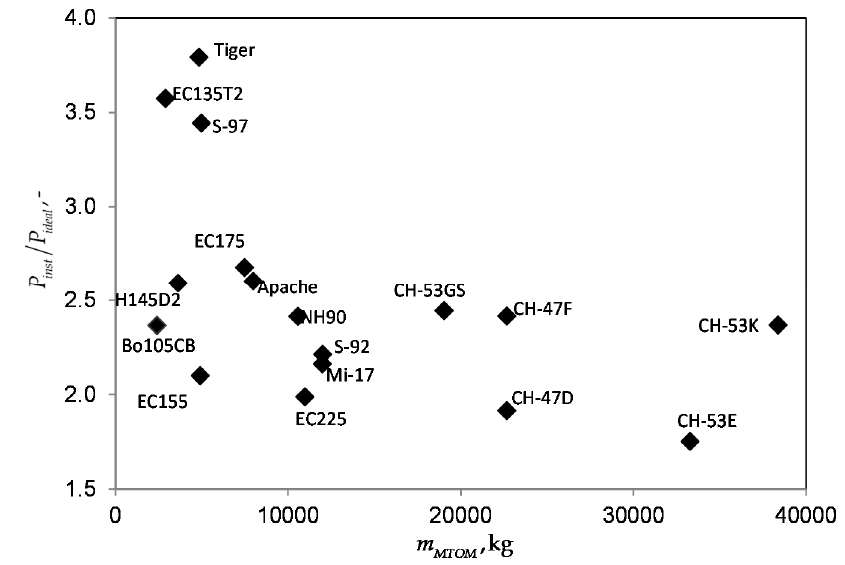
Figure 9. Ratio of the installed and ideal power in hover versus MTOM for existing helicopters.